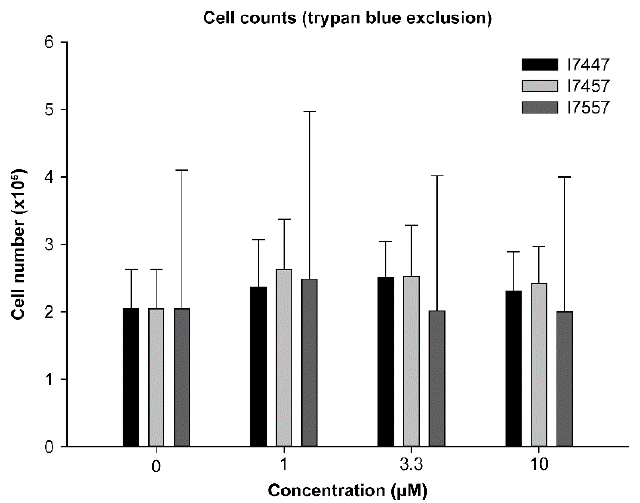
Figure 2. 6-MITC, I7447, and I7557 did not significantly affect the viability of dendritic cells at 1, 3.3, and 10 μ M.